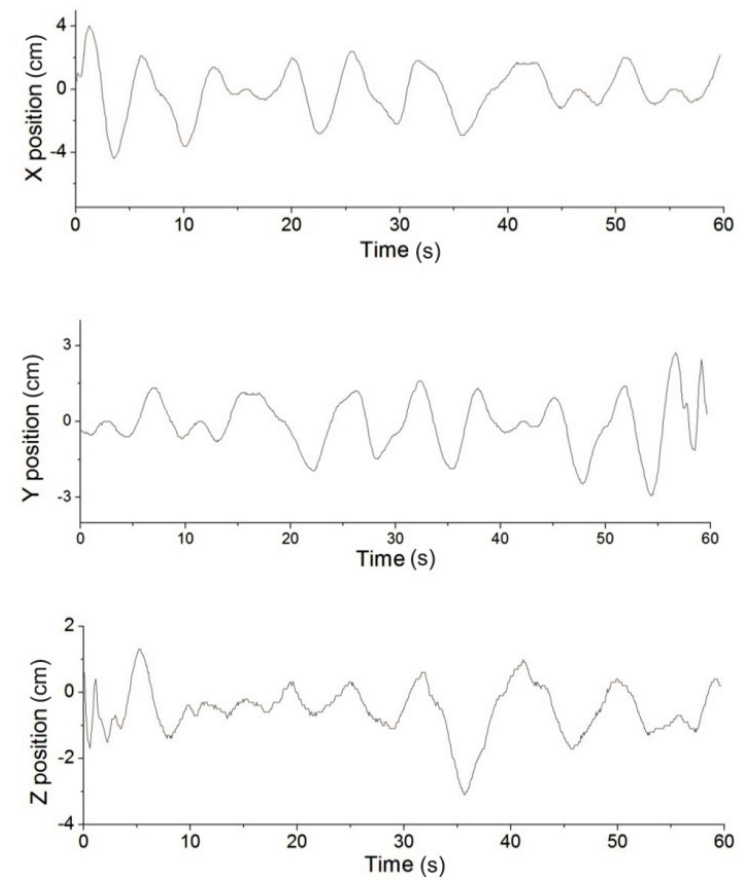
Figure 12. Position error in the X , Y and Z positions. The value remains ±4 cm. The Z position is more accurate than the X and Y